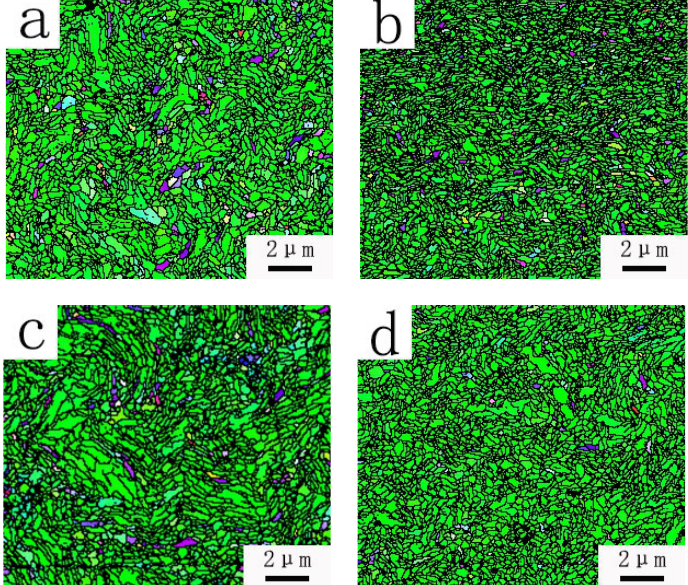
Figure 5. EBSD orientation maps. ( a ) ϕ 0.50 mm tungsten wire prepared by Process 1, ( b ) ϕ 0.50 mm tungsten wire prepared by Process 2, ( c ) ϕ 0.50 mm tungsten wire prepared by Process 3, ( d ) ϕ 0.50 mm tungsten wire prepared by Process 4.